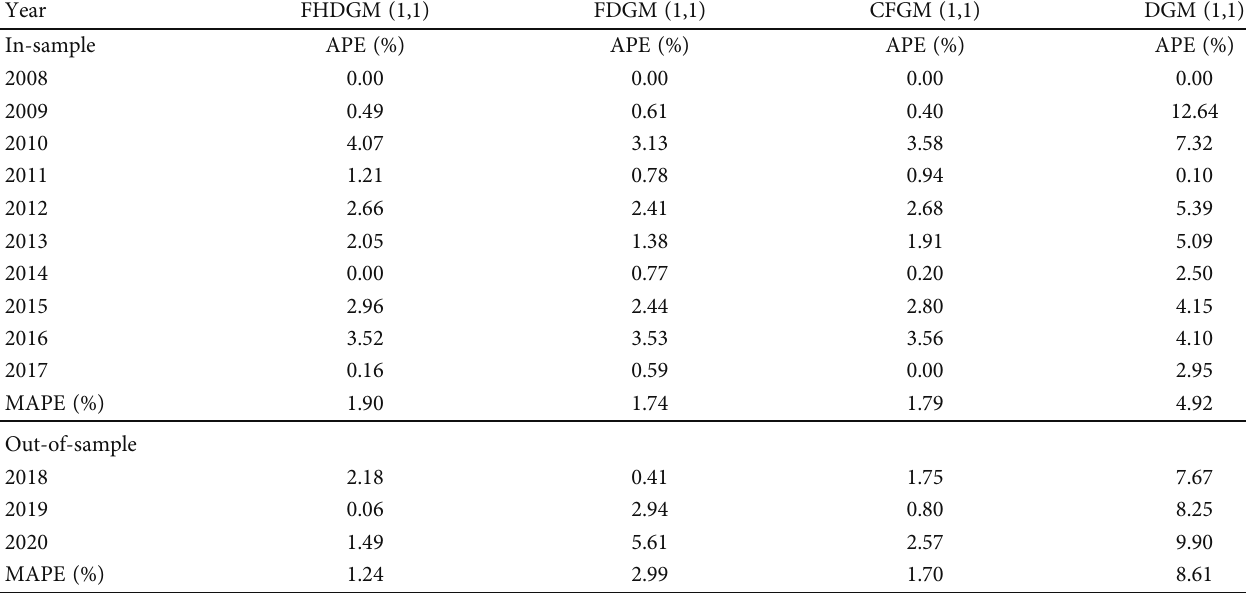
Table 12: Values of APE and MAPE are generated by the four